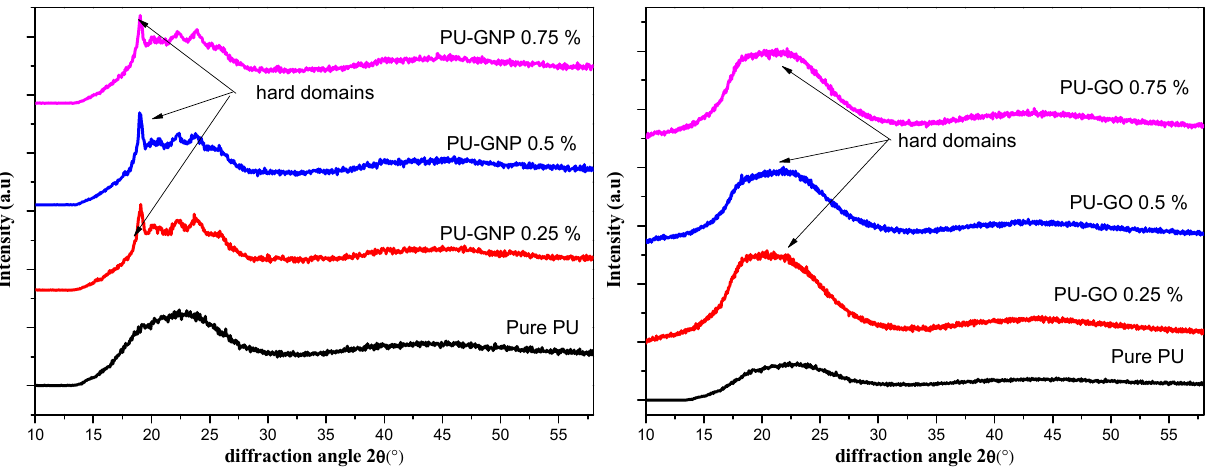
Figure 6. Semi-log plot of Y-axis of wide-angle X-ray-scattering intensity for PU/GNP/GO nano-composites.